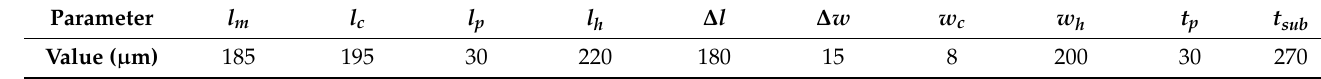
Figure 8. Displacement of the detector with different order of composite cell array. Table 3. The optimized parameters of detector.